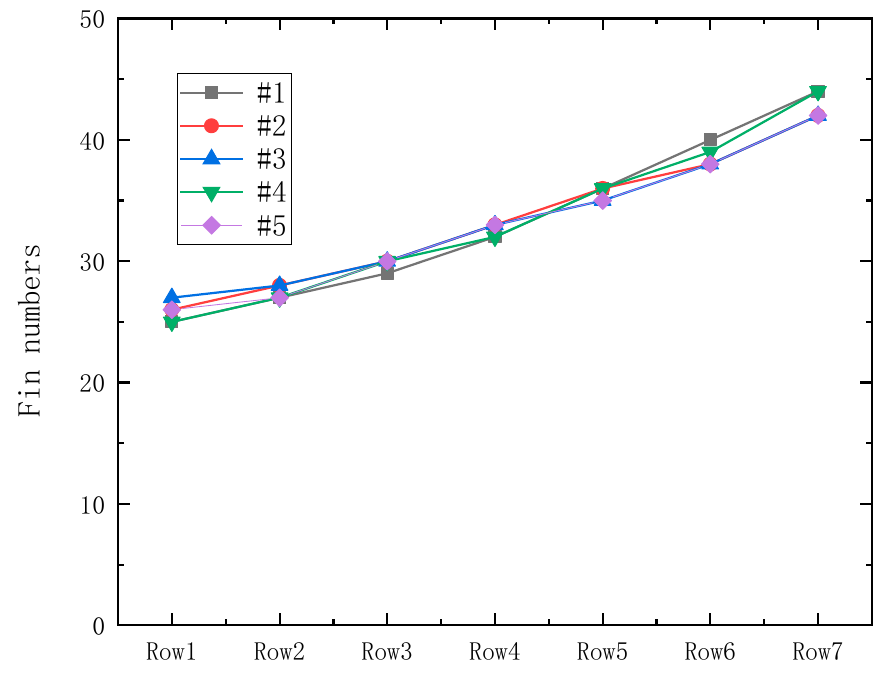
Figure 13. Optimized fin distribution under different temperature and humidity conditions.